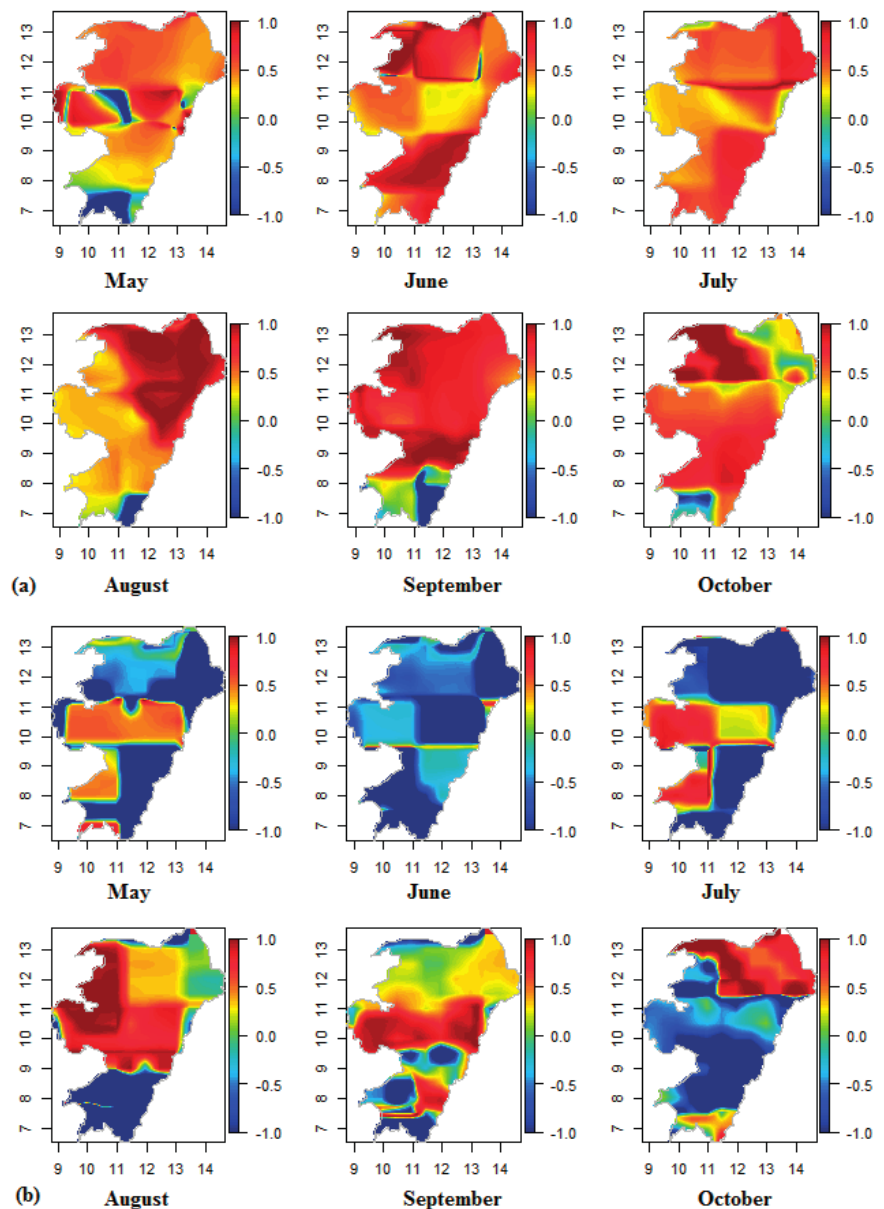
Figure 7. The F-skill values of ( a ) monthly rainfall in mm and ( b ) the frequency of the number of rain days in a month (in days) from May–October. The axes show the latitude and longitude coordinates in